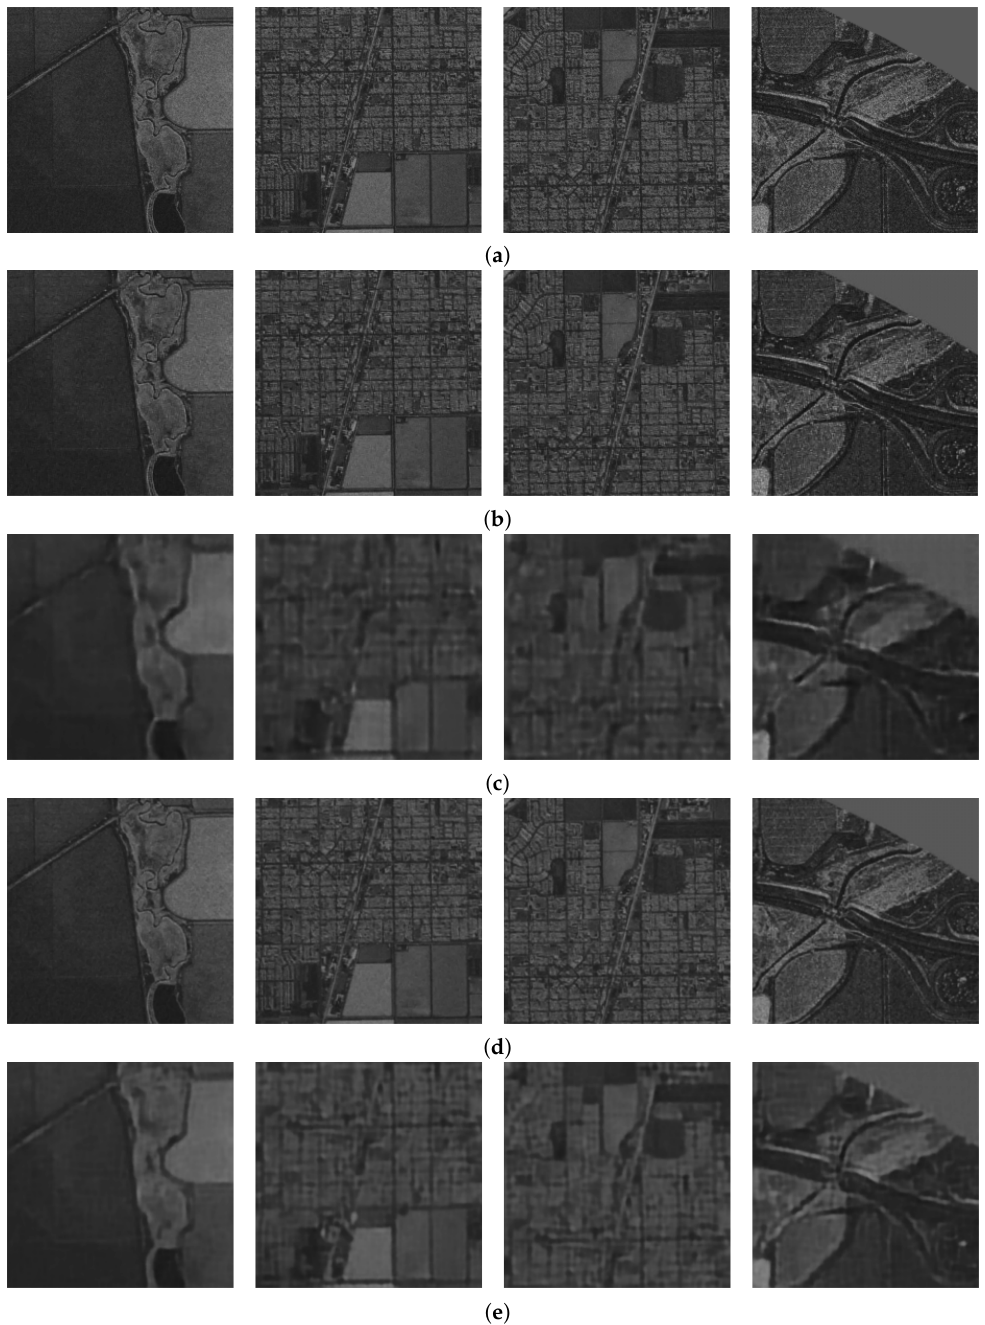
Figure 7. Examples of outputs generated by four neural networks configuration juxtaposed with input images. Outputs of the neural networks learned using filtered labels are slightly less sharp. All the presented networks can compress the data in the images and decode it very well. ( a ) Original Inputs. ( b ) Fully CNN—Without filters. ( c ) Compressing CNN—Without filters. ( d ) Fully CNN—With filters. ( e ) Compressing CNN—With